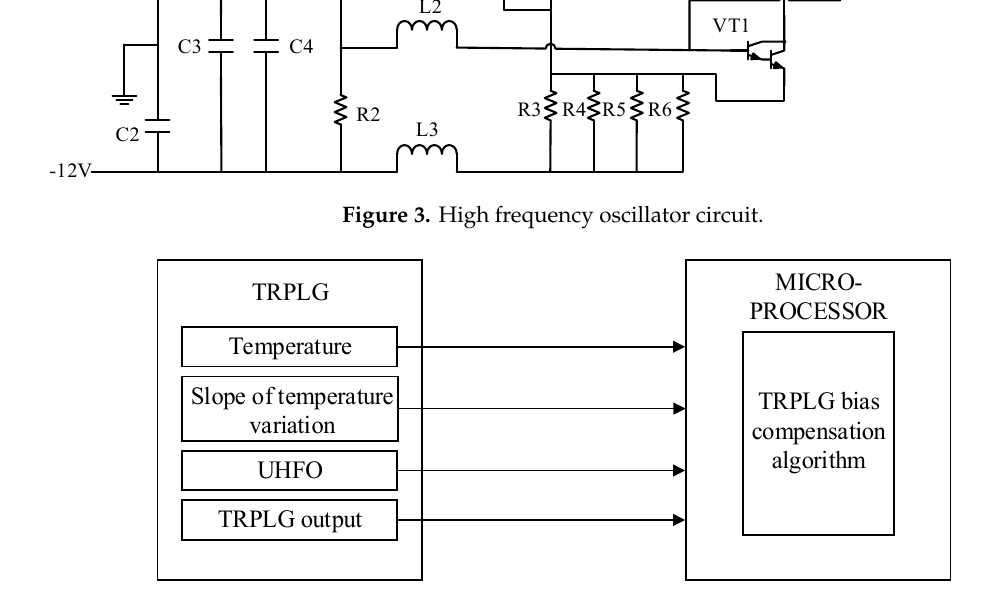
Figure 4. The hardware structure of TRPLG bias compensation.